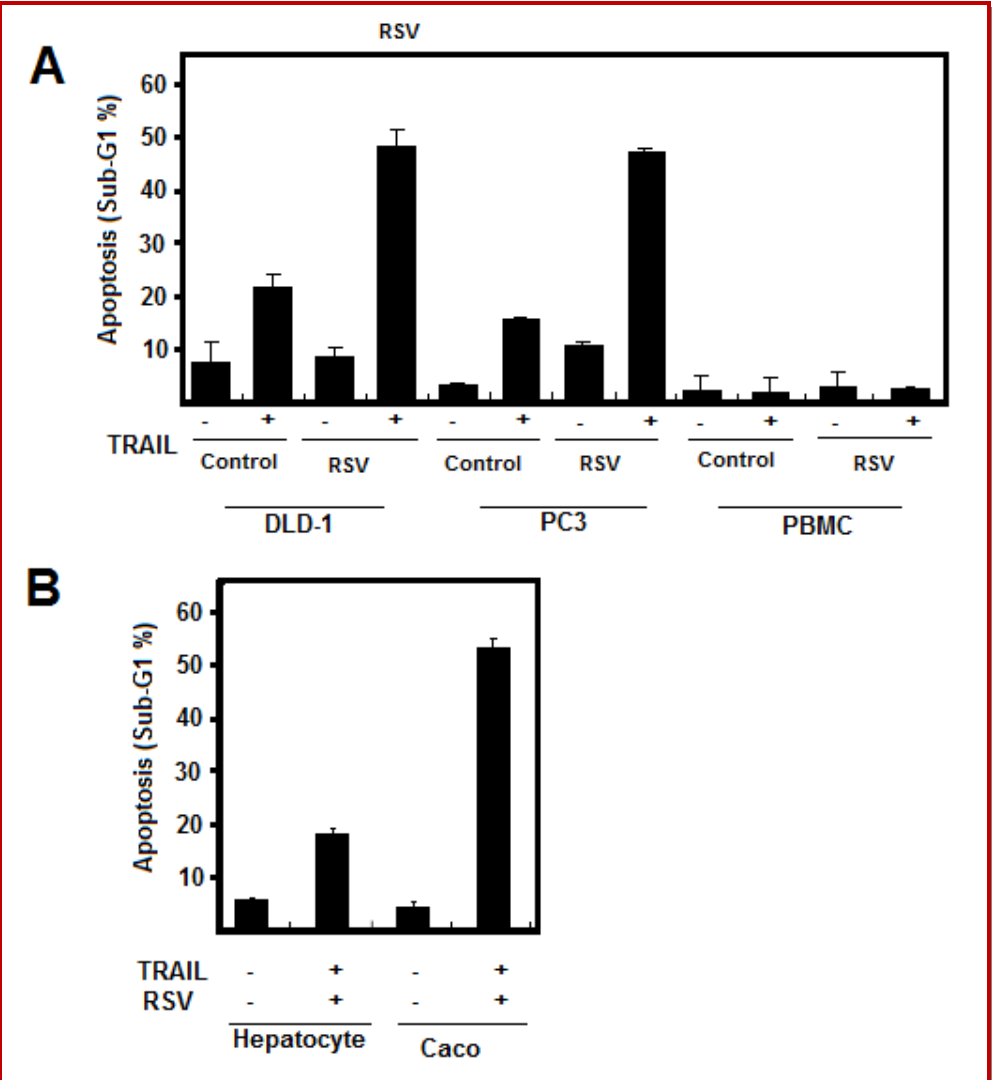
Figure 5: (A) Human colon cancer DLD-1 cells, prostate cancer PC3 cells and PBMC cells were treated with 40 µM resveratrol and/or 5 ng/mL of TRAIL for 24 hours. (B) Normal human hepatocytes and colon cancer Caco cells were treated as shown in (A). The values shown are means (n = 3); bars, ±